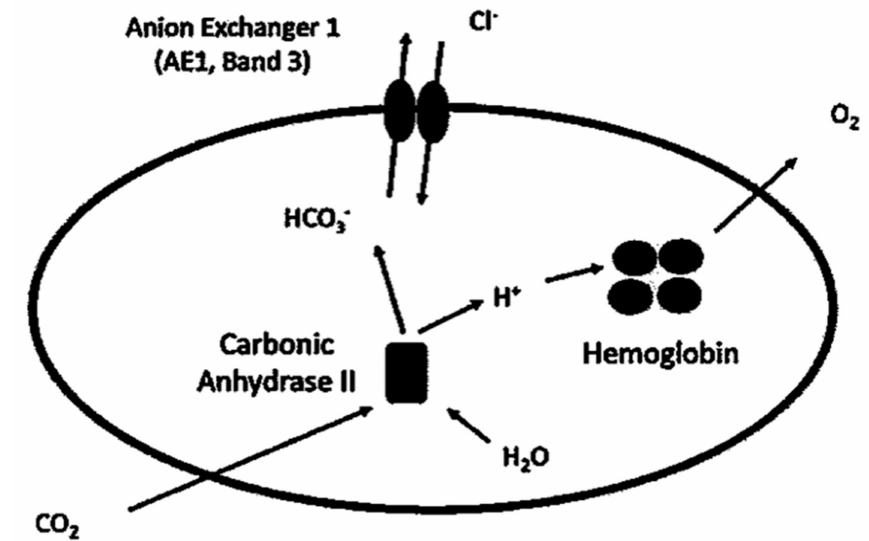
Figure1. AnionexchangethroughBand3protein[13]. Attissuelevel, CO 2 di ff usesthrougherythrocytes membrane and is converted with H 2 O to HCO 3 − and H + by the enzyme carbonic anhydrase II. HCO 3 − is extruded in exchange for Cl − , while H + is bu ff ered by hemoglobin. At pulmonary level, the direction of ion exchange through Band 3 protein is reversed (not shown), with HCO 3 − entering the cell in exchange for Cl − and with CO 2 finally expired by